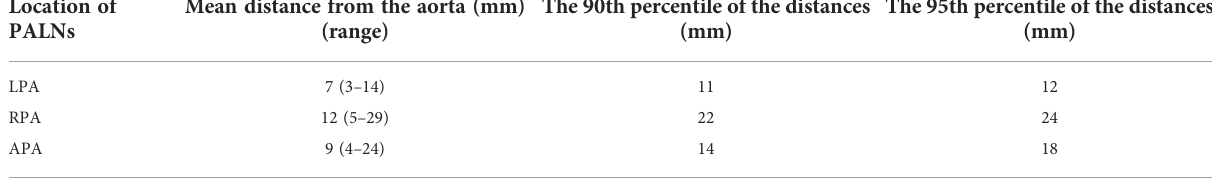
TABLE 2 Distance from the aorta to the volumetric center of the PALN in LN16a2 and LN16b1 in the study cohort. Location of Mean distance from the aorta (mm) PALNs (range)